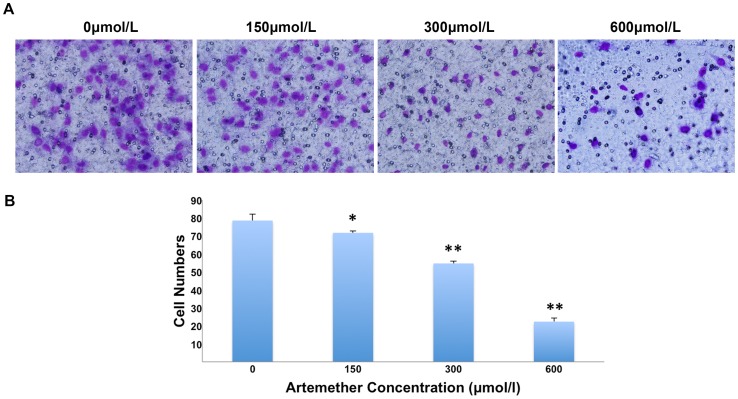
Artemether inhibited the invasiveness of U87 cells.(A) U87 cells were treated with artemether at various concentrations of 0, 150, 300 and 600 µmol/L for 48 h. Serum free L-DMEM served as a negative control. Cells migrating to the underside surface of Transwell filter were stained with Giemsa staining and photomicrographed, representing the invasiveness ability of U87 cells. (B) Statistical analysis of invasive cell numbers. The invasiveness of U87 cells was attenuated with the increased concentration of artemether. n = 4. *P<0.05, **P<0.01 (compared with 0 µmol/L group).